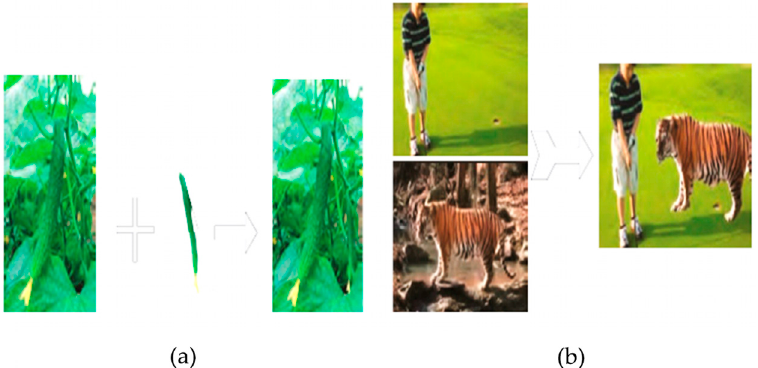
Figure 6. ( a ) Forged Image in CASIA ITDE v1 ( b ) Forged Image in CASIA ITDE v1.